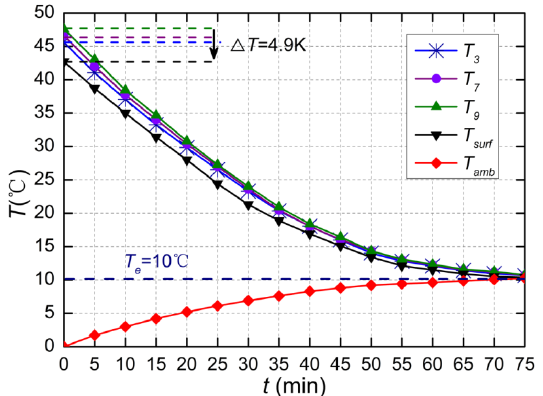
Figure 14. Measured temperatures after switching off the electronic load for thermal relaxation of the cell in an initial ambient temperature of 0 °C, for three measurement positions of the different local temperatures referred to in Figure